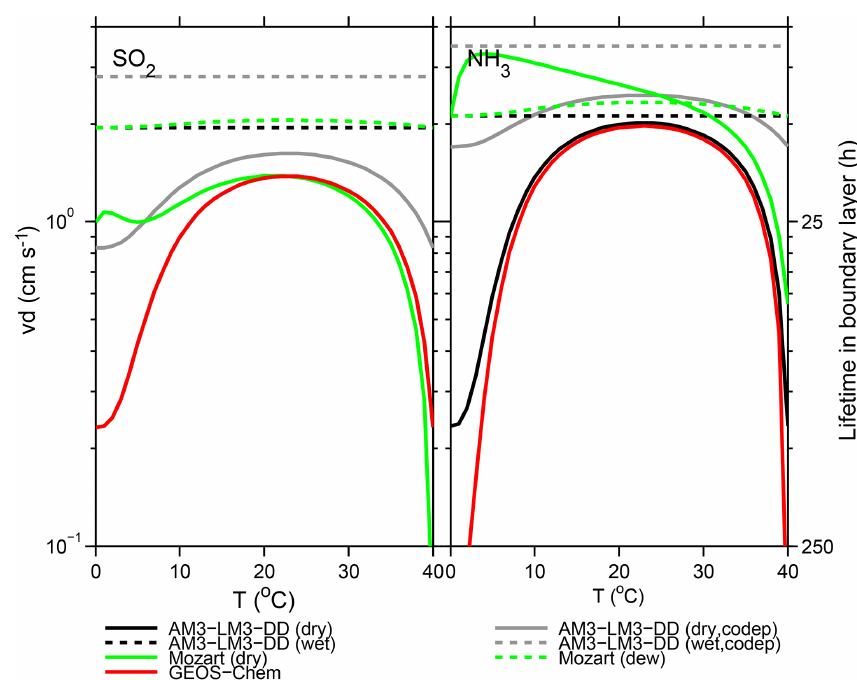
Figure 2. Simulated deposition velocity of NH 3 and SO 2 over a coniferous forest (LAI = 5, u (cid:63) = 0 . 5ms − 1 , RH = 80%) at different canopy wetness and temperatures. To facilitate comparison across models, we use the same R a = 20sm − 1 , R b (Hicks et al., 1987), and R s (Wesely, 1989) for all models. Solar irradiation increases linearly from 0 to 800Wm − 2 with temperature. We neglect deposition to the ground and stems. Codep refers to the decrease in R sf , v ( SO 2 ) and R sf , v ( NH 3 ) associated with base and acid deposition, respectively. For illustrative purposes, the ratio of acid to base deposition is set to 0.5 for SO 2 and 2 for NH 3 . The lifetimes of SO 2 and NH 3 are estimated assuming a boundary layer height of 900m. GEOS-Chem and AM3-LM3–DD produce identical results for SO 2 under dry conditions.